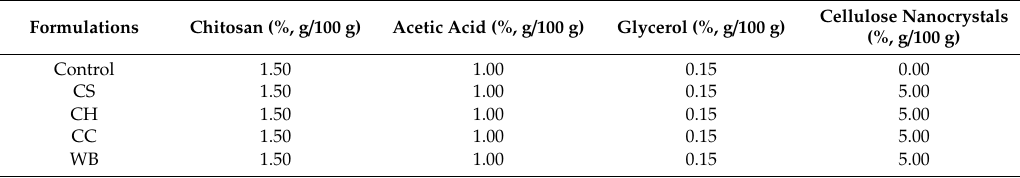
Cellulose Nanocrystals (%, g / 100 g)